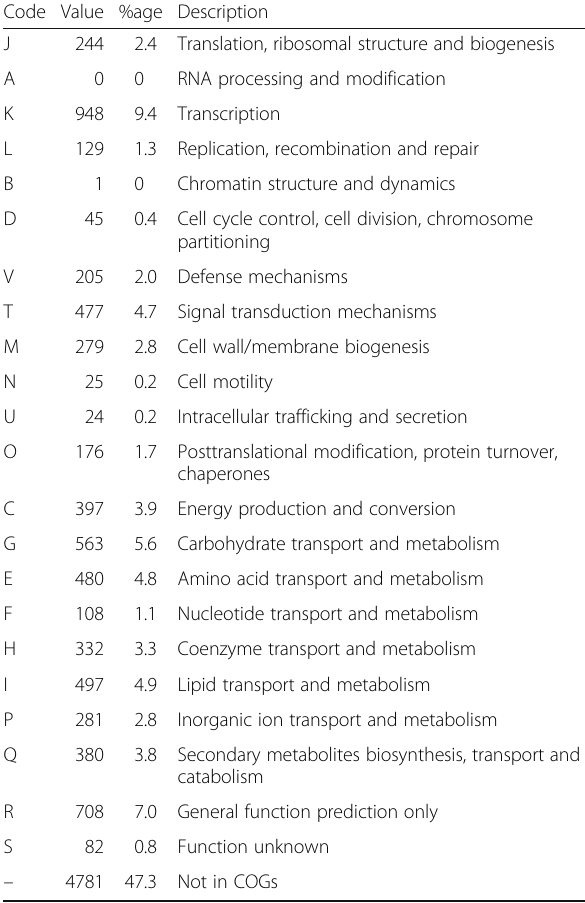
Table 4 Number of genes associated with general COG functional categories